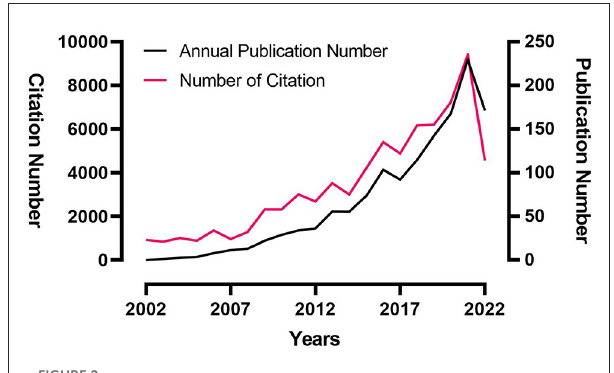
FIGURE2 Growth trends in annual publication and citation numbers.